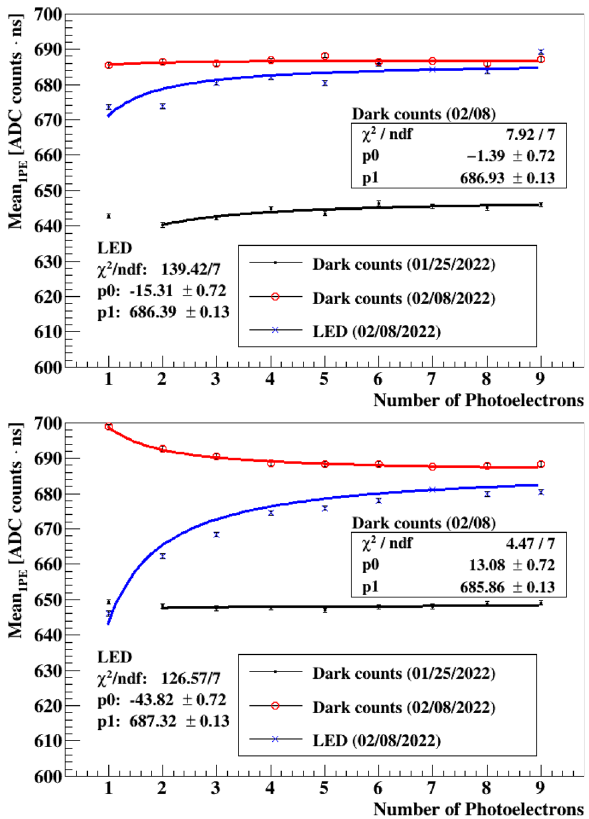
Fig. 8 Mean 1PE distributionsoftopSiPM(top)andbottomSiPM(bot- tom) obtained from different